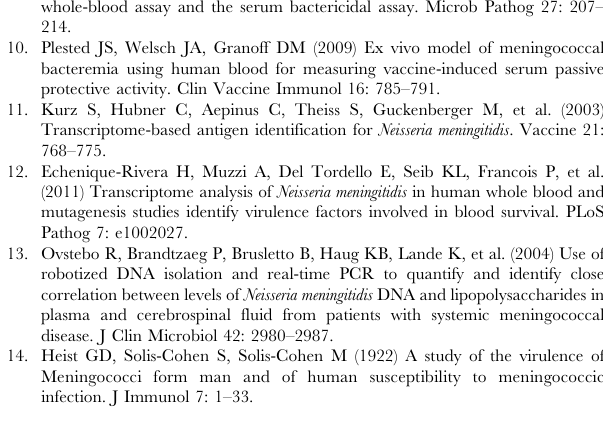
Table S1 Correlation of transcriptional profiles between indi- vidual biological replicates (compared within each biological group against biological replicate 1). Table S2 Number of differentially regulated meningococal genes during blood co-cultivation. Table S3 Complete list of differentially expressed meningococ- cal genes during blood co-cultivation. Table S4 Primers and probes used for real-time